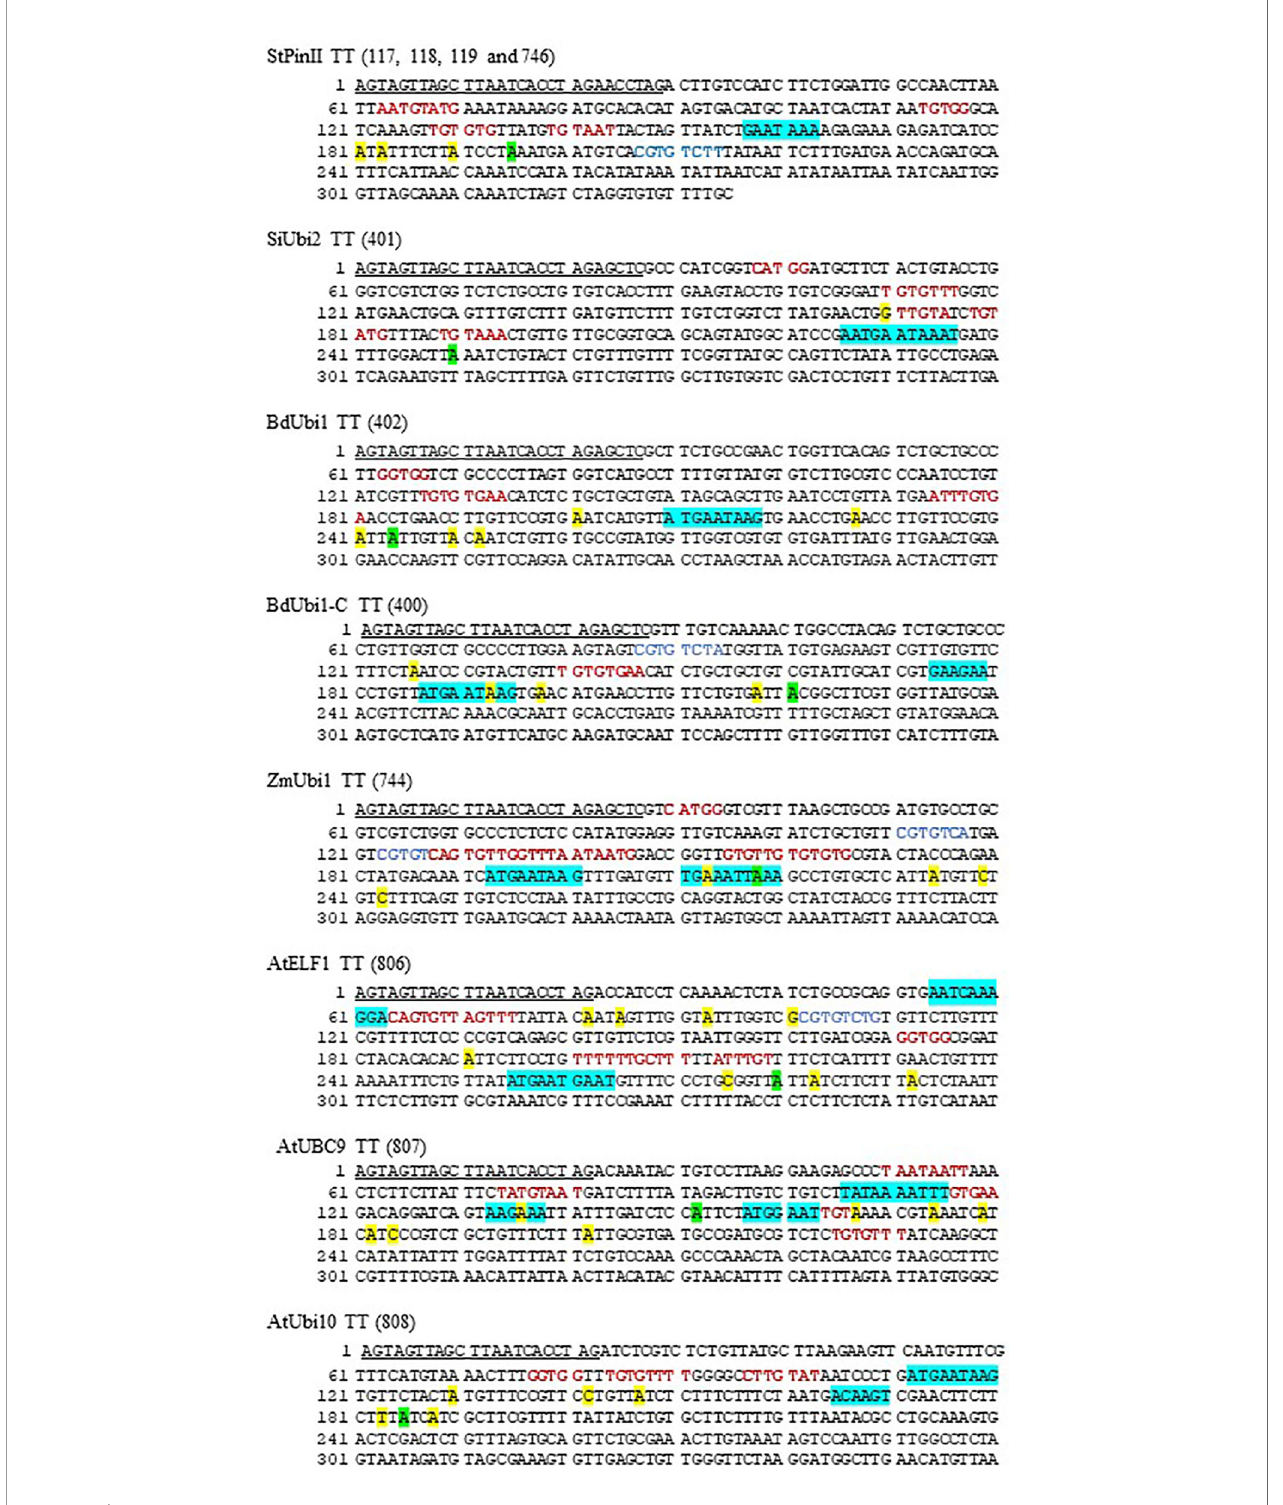
FIGURE 4 | DNA sequence of distinct TTs deployed in constructs of transgenic maize. The fi rst bp in the sequence is the last bp of the reporter gene and coordinate 1 of the diagrams in Figure 3 . The underlined sequences were present between the reporter gene coding sequence and the TTs. The turquoise, green and yellow highlighted sequences depict PPSGs and overlapping hexamers as shown in Table 1 , major poly(A) sites representing most abundant mRNA as shown in Figure 3 , and non-major poly(A) sites as shown in Figure 3 , respectively. The letters in red and blue font are putative FUE motifs and mRNA stability motifs (e.g., CGTGTCTT of StPinII ), respectively, that were previously described ( Supplementary Table S2 ). If two motifs overlapped, only one of the motifs is